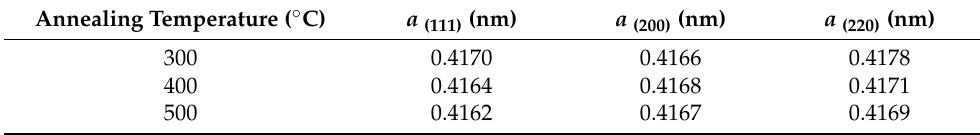
Table 1. Lattice parameters of NiO films in different directions at different annealing temperatures.